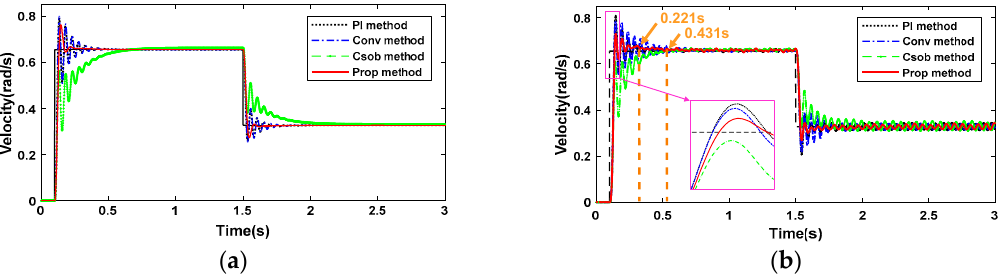
Figure 11. Velocity ripple elimination from 0.66 rad/s reduced to 0.33 rad/s with motor-side controller: ( a ) simulations; ( b ) experiments. ( a ) simulations; ( b )